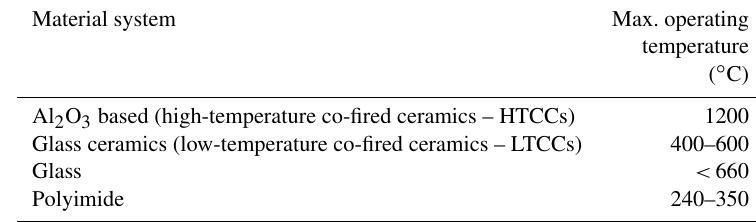
Table 2. Materials for system integration with estimated maximum operating temperature (Damjanovic, 1998; Zang et al.,